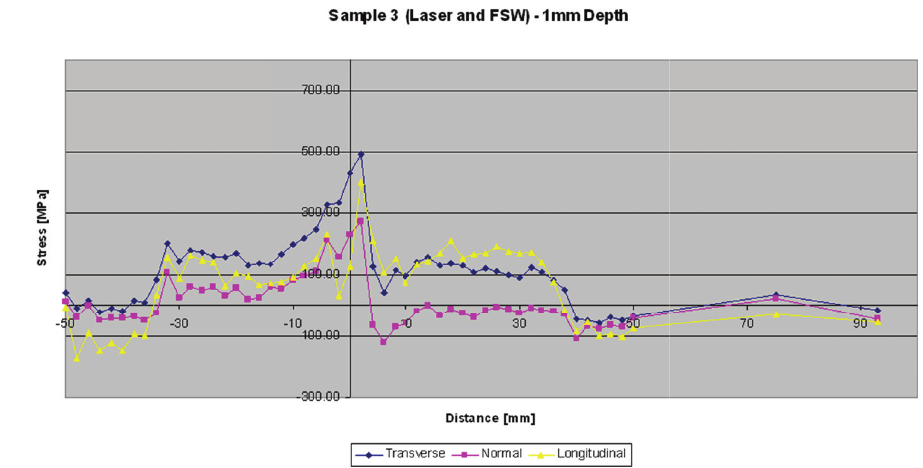
Figure 8b: neutron and s and other com he accuracy of esidual